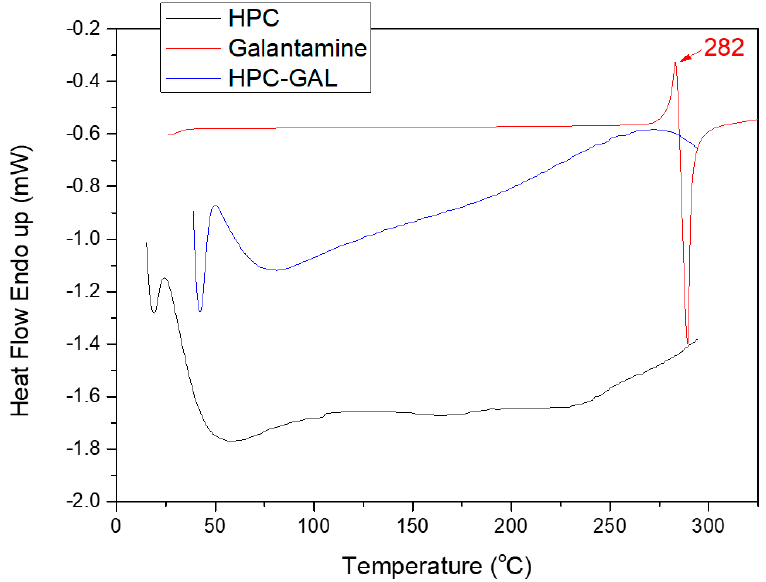
Figure 4. Differential scanning calorimetry (DSC) thermographs of HPC and galantamine before and after the latter’s adsorption.